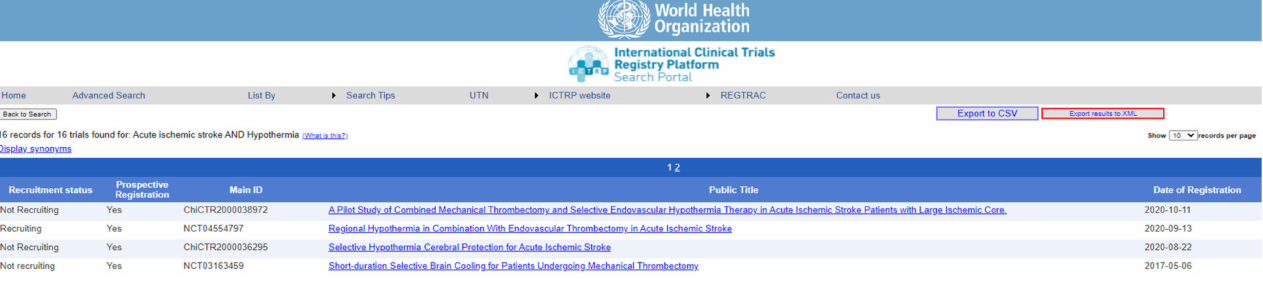
Figure 7. Clinical trials for Hypothermia/Cooling interventions in acute ischemic stroke on https: //trialsearch.who.int (accessed on 16 December 2021).